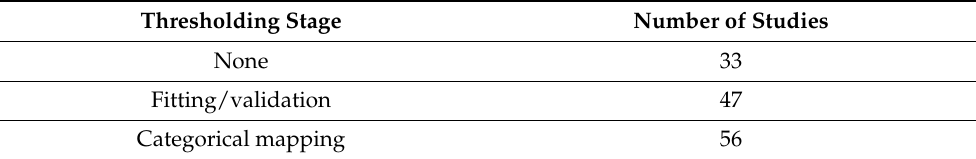
Table 8. Number of studies reviewed using a thresholding stage during the classification process. Thresholding